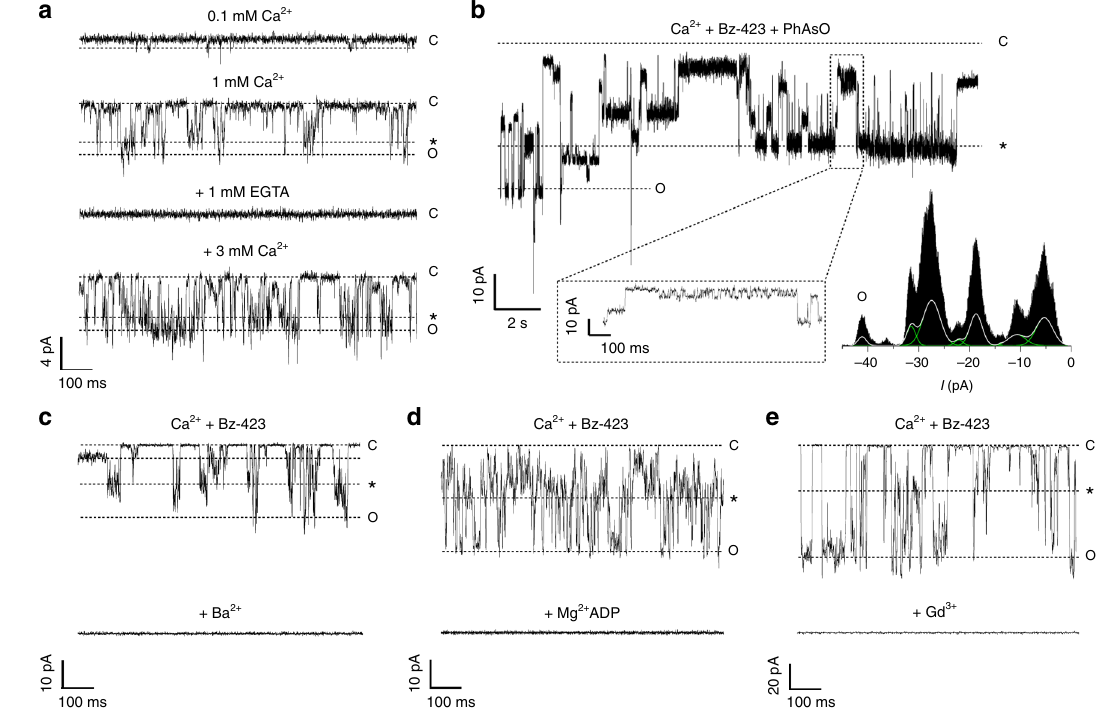
Fig. 3 Activation and inhibition of bovine F-ATP synthase channels. a F-ATP synthase channel activity was elicited after reconstitution of the protein into proteoliposomes and insertion in the bilayer in the presence of increasing concentrations of Ca 2 + . Addition of EGTA suppressed channel activity, which was reactivated by the further addition of Ca 2 + . Conductance at 0.1 mM Ca 2 + was 30 ± 10 pS and at 1 – 3 mM Ca 2 + was 117 ± 17 pS (SEM, n = 3); V = – 60 mV. b Representative current trace after direct incorporation of F-ATP synthase showing long lasting and complex channel activity after addition cis of 3 mM Ca 2 + , 0.1 mM Bz-423, and 0.2 mM PhAsO; V cis = – 80 mV. The closed state is denoted with C, the most frequent subconductance state with an asterisk, and the maximal open state with O. Inset, low conductance (30 pS) activity can be observed in the same trace, together with the higher conductance states. Multiple current levels are distinguishable as different peaks in the current amplitude histogram shown below the current tracings (see also Supplementary Fig. 7a from the same experiment). c – e Current traces were recorded after direct incorporation of F-ATP synthase and addition of increasing concentrations of Ca 2 + up to 3 mM in the presence of 0.15 mM Bz-423; after a stable channel activity was reached, inhibitors were added. From the left: current traces before and after addition of c 5 mM Ba 2 + ([Ca 2 + ] = 3 mM, G max = 500 pS); d 1 mM Mg 2 + ADP ([Ca 2 + ] = 0.3 mM, G max = 600 pS); and e 1 mM Gd 3 + ([Ca 2 + ] = 0.66 mM, G max = 1300 pS). Traces are representative of at least nine replicates for each inhibitor. The source data underlying panel a are provided as a Source Data fi